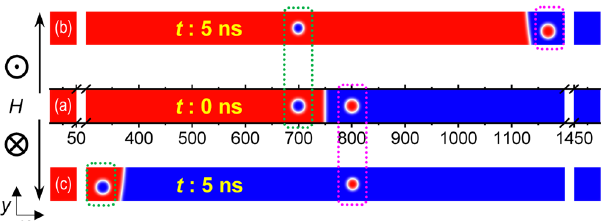
Fig. 8 Selective delivery of a set of skyrmions by the fi eld polarity. a In such con fi guration, a domain wall sits in between two sets of skyrmions. b , c A perpendicular magnetic fi eld ( H ) in a given direction will shift only one set of skyrmions in a certain direction without affecting the other set. Note that, one skyrmion or more can be included in each set. The strengths of perpendicular magnetic anisotropy and